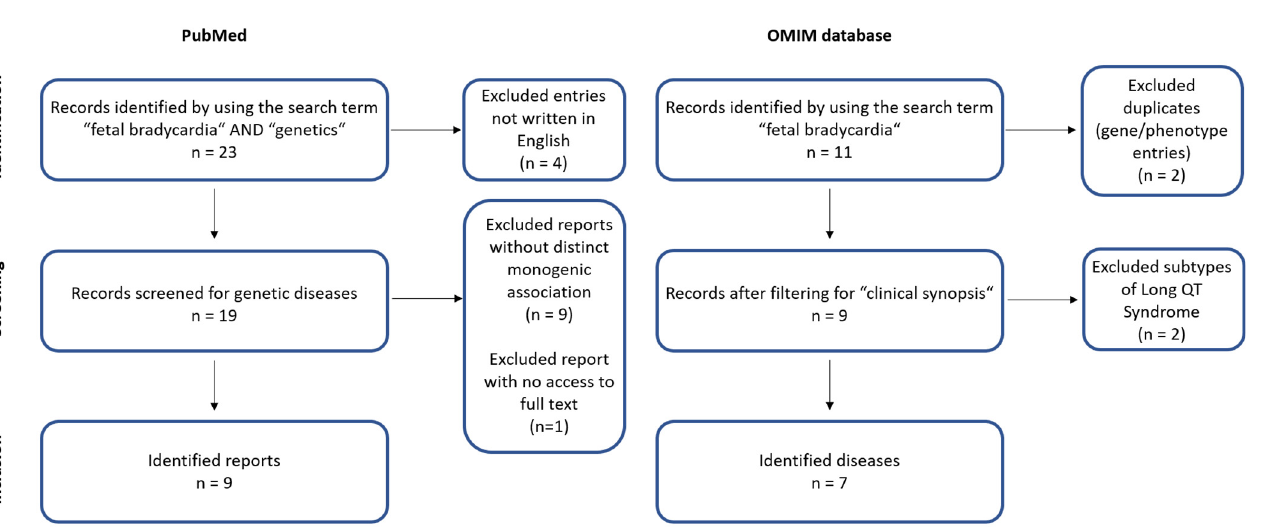
Figure 1. Flowchart depicting the performed OMIM database- and PubMed-based literature search.